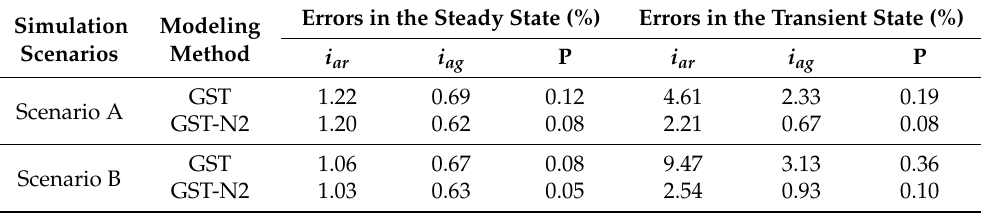
Table 2. Comparison of paradigm errors in different simulation